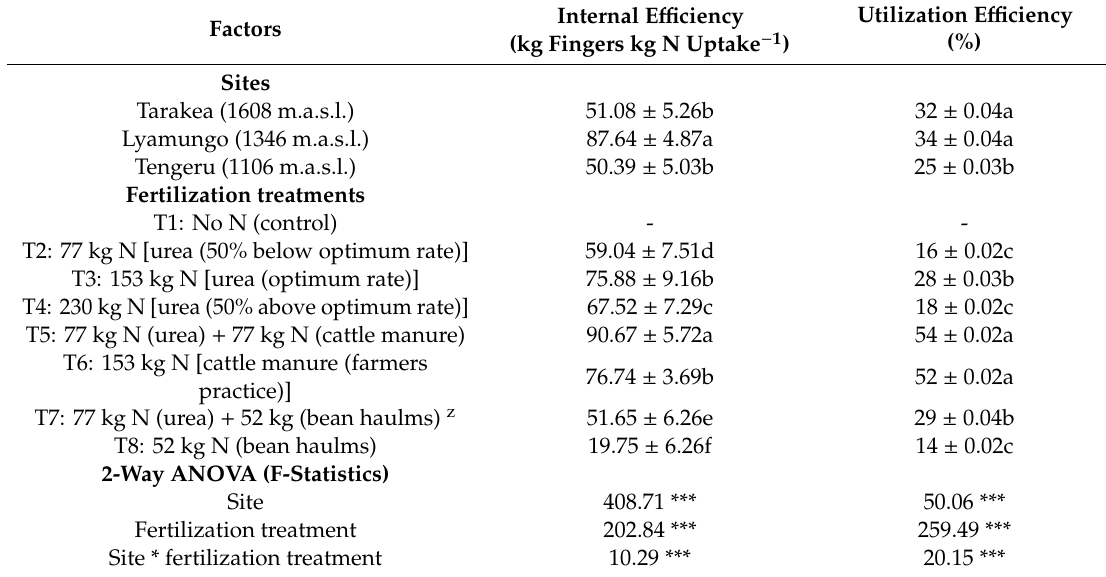
Table 8. E ff ects of fertilization treatments on the e ffi ciency of N fertilizer applied to the crop. Internal E ffi ciency Factors